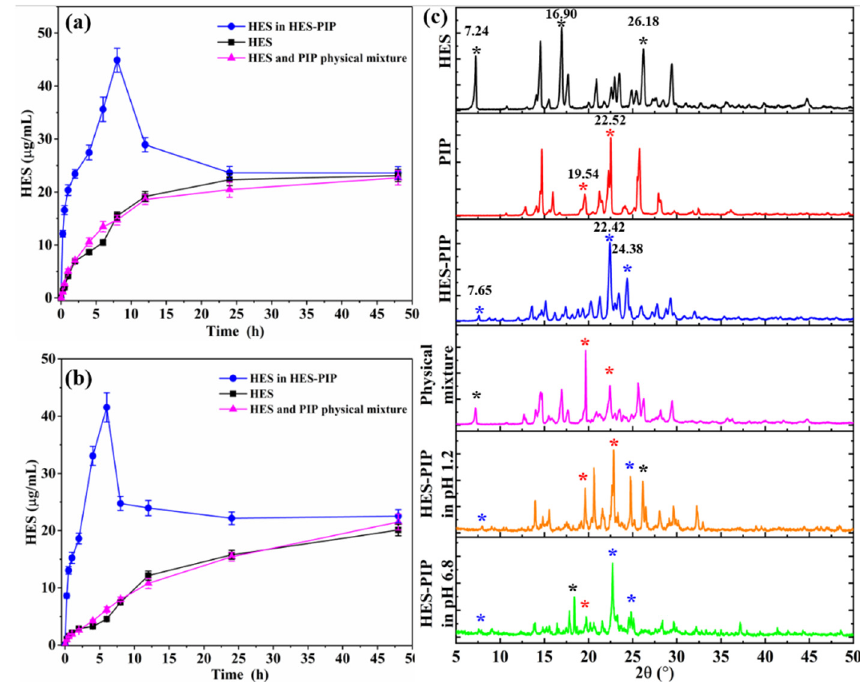
Figure 6. Equilibrium solubility of HES, HES in HES–PIP in simulated gastrointestinal juice ( a , pH = 1.2), ( b , pH = 6.8), and PXRD patterns after 48 h solubility test ( c ). The same color of symbol ( * ) represents the characteristic peak of the same substance.